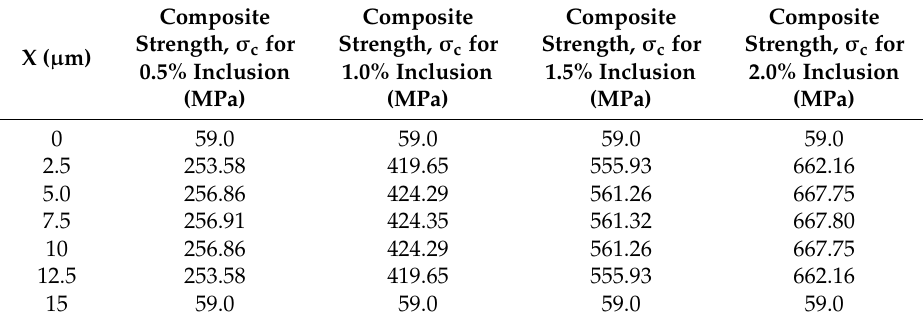
Table 4. Calculated strength over the MWCNT length for different inclusion percentages.